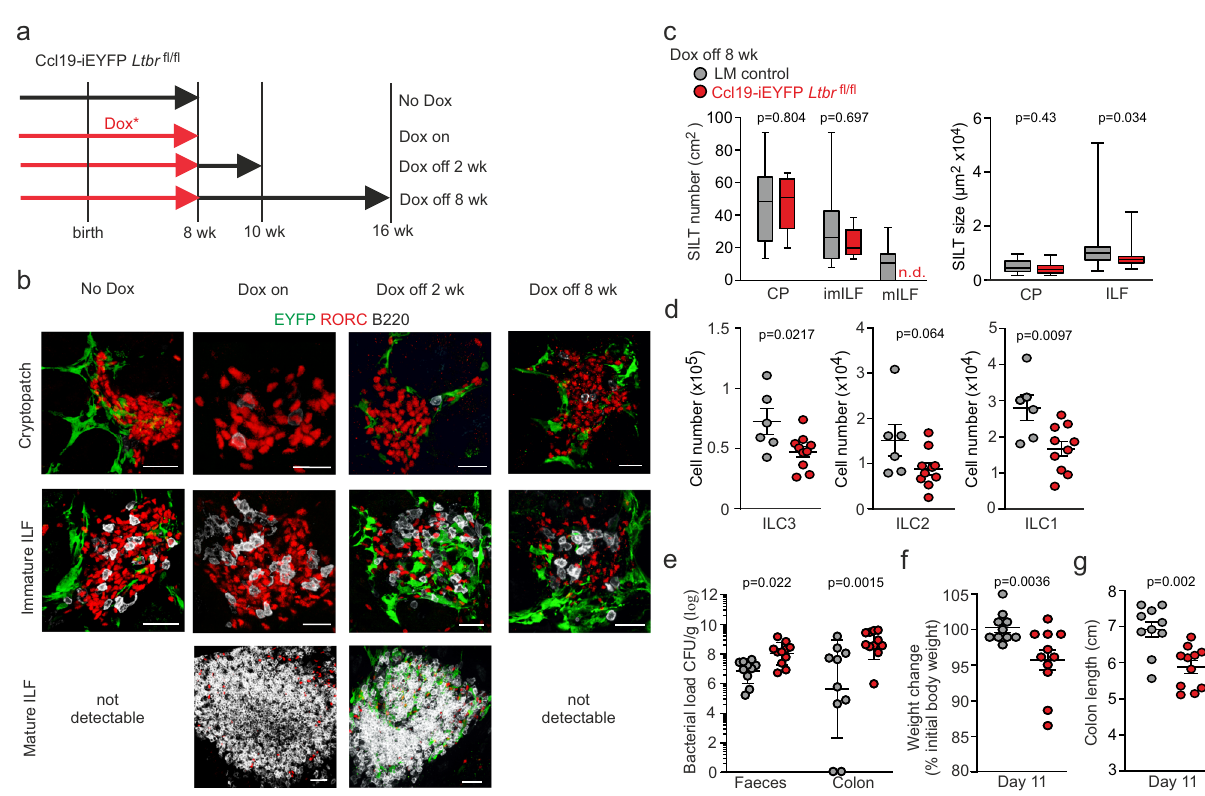
Fig. 4 SILT maturation and ILC sustenance in the absence of persistent LT β R signaling in FRCs. a Schematic timeline of non-antibiotic Dox treatment regime b Representative images of SILT structures in different conditions analyzed by confocal microscopy after staining with the indicated antibodies. Scale bar, 20 μ m in CP, 30 μ m in imILF, and 30 μ m in mILF. c Number and size of SILT structures detected in the small intestine from Ccl19-iEYFP Ltbr fl / fl mice and co-housed littermate controls after Dox withdrawal for 8 weeks. d Cell number of ILC subsets from Ccl19-iEYFP Ltbr fl / fl mice and co-housed littermate controls after Dox withdrawal for 8 weeks. e Bacterial concentration in faeces and colonic tissue on day 11 after C. rodentium infection of Ccl19- iEYFP Ltbr fl / fl mice and co-housed littermate controls after Dox withdrawal for 8 weeks. f , g . Weight change ( f ) and colon length ( g ) on day 11 after C. rodentium infection in Ccl19-iEYFP Ltbr fl / fl mice and co-housed littermate controls after Dox withdrawal for 8 weeks. b Images are representative of at least four mice. c n = 13 and 8 mice from three independent experiments in the left panel, n = 27 and 18 in CP and n = 26 and 16 in ILF from 5 mice with two independent experiments in the right panel. median ± interquartile ranges. d n = 6 and 10 mice from three independent experiments, mean ± SEM. e n = 10 and 11 mice from three independent experiments, geometric mean ± SD. f , g n = 10 and 11 mice from three independent experiments, mean ±